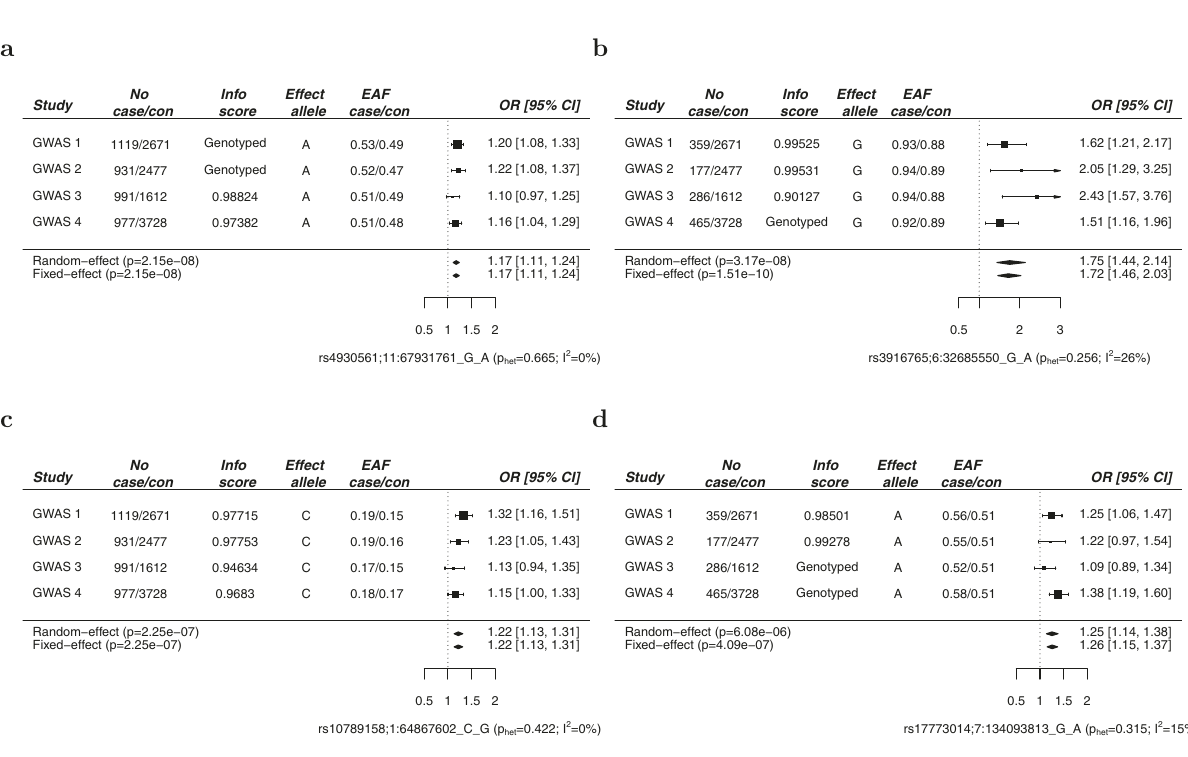
Fig. 2 Forest plots for 4 new loci associated with acute myeloid leukemia. Study cohorts, sample sizes (case and controls (con)), imputation (info) score, effect allele, effect allele frequencies (EAF), and estimated odds ratios (OR) for rs4930561 ( a ), rs3916765 ( b ), rs10789158 ( c ), and rs17773014 ( d ). The vertical line corresponds to the null hypothesis (OR = 1). The horizontal lines and square brackets indicate 95% con fi dence intervals (95% CI). Areas of the boxes are proportional to the weight of the study. Diamonds represent combined estimates for fi xed ‐ effect and random ‐ effect analysis. Cochran ’ s Q statistic was used to test for heterogeneity such that P HET > 0.05 indicates the presence of non-signi fi cant heterogeneity. The heterogeneity index, I 2 (0 – 100) was also measured which quanti fi es the proportion of the total variation due to heterogeneity. All statistical tests were two-sided and no adjustments were made for multiple